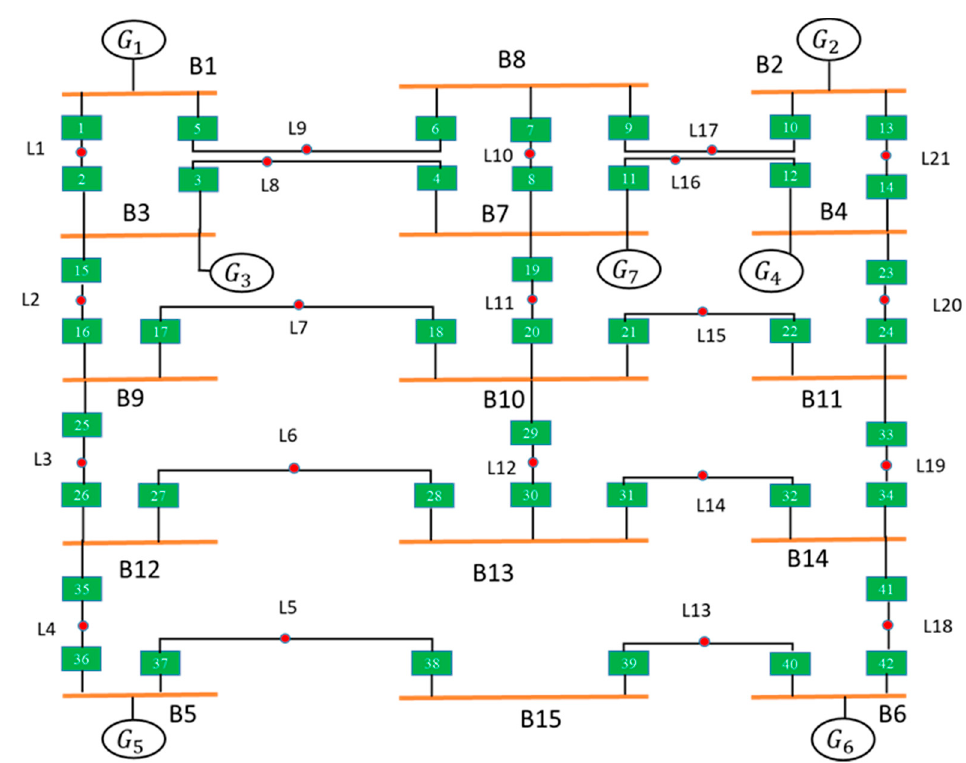
Figure 9. IEEE 15 bus system. Table 5. Optimum values of TDS for the IEEE 15 bus system.